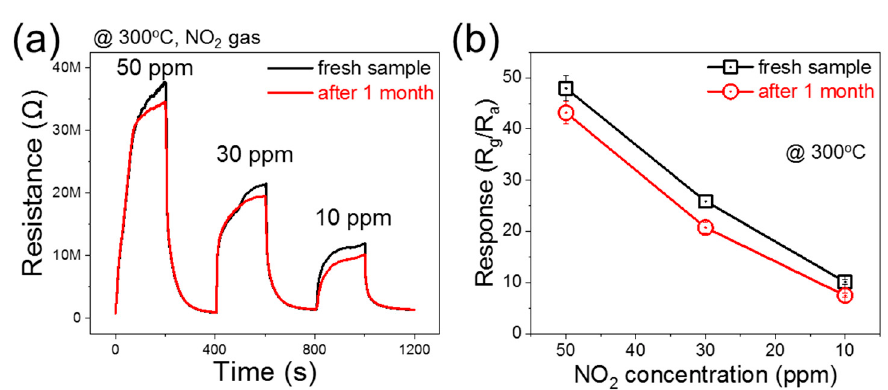
Figure 14. Long ‐ term stability study of optimized gas sensor to various concentrations of NO 2 gas at 300 °C after one month. ( a ) dynamic resistance curves; ( b ) corresponding calibration curves.